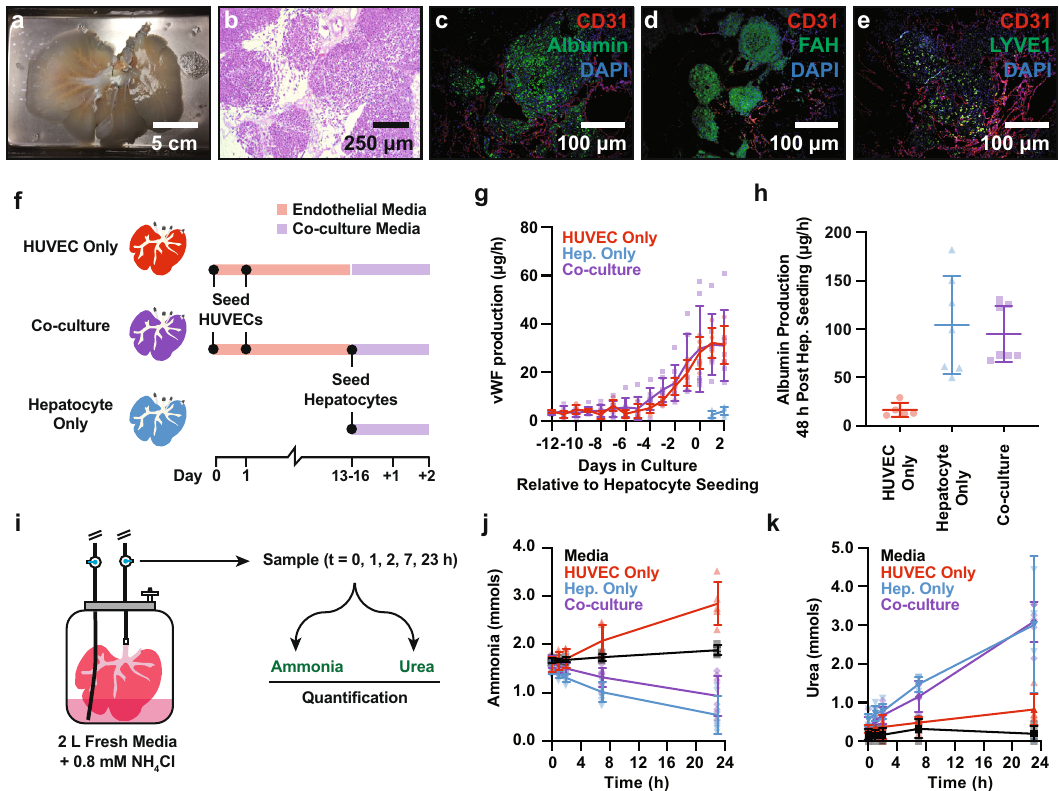
Fig. 2 Histological and functional characterization of BEL constructs. a Representative photograph of a BEL seeded with HUVECs and porcine hepatocytes. b Hematoxylin and eosin staining of representative co-culture BEL tissue sections fi xed 48h after seeding hepatocytes. c – e Immuno fl uorescent staining of cell lineage markers in non-serial tissue sections 48h after seeding hepatocytes: ( c ) CD31 & albumin; ( d ) CD31 & FAH; ( e ) CD31 and LYVE1. f Schematic depicting seeding and culture timeline for HUVEC only, hepatocyte only, and co-culture BEL constructs used in ( g , h , j , k ). g vWF production in grafts before and after hepatocyte seeding. Data from independent HUVEC only ( n = 5), hepatocyte only ( n = 7), and co-culture ( n = 7) BEL constructs are shown. Error bars denote the mean and standard deviation at each time point. h 24-h average albumin production in co-culture grafts 48h following hepatocyte seeding. Data from independent HUVEC only ( n = 5), hepatocyte only ( n = 7), and co-culture ( n = 7) BELs are shown. Error bars denote the mean and standard deviation. i Schematic of in vitro ammonia clearance and urea production assay. Ammonium chloride is added to the bioreactor media at a concentration of 0.8 mM. Ammonia and urea levels are measured in media samples taken at t = 0, 1, 2 7, and 23h following the addition of ammonium chloride. Error bars denote the mean and standard deviation each time point. j , k Ammonia clearance ( j ) and urea production kinetics ( k ) following the addition of ammonium chloride to the bioreactor perfusion media. Data from independent HUVEC only ( n = 5), hepatocyte only ( n = 7), and co-culture ( n = 7) BELs, media only controls ( n = 4) are shown. Error bars denote the mean and standard deviation each time point. BEL — bioengineered liver; FAH — fumarylacetoacetate hydrolase; CD31 — cluster of differentiation 31; LYVE1 — lymphatic vessel endothelial hyaluronan receptor 1; vWF — von Willebrand